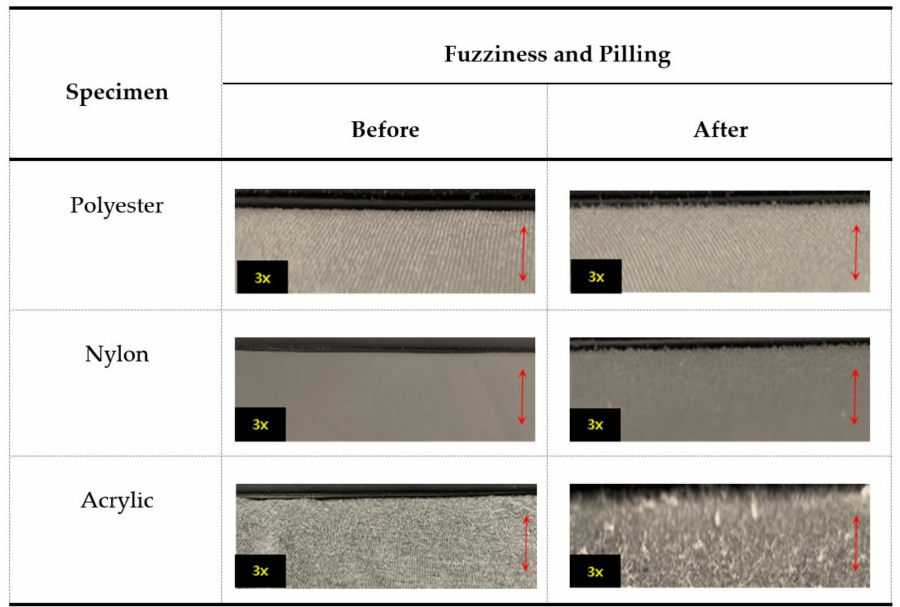
Figure 7. Digital microscopy images (3 × ) of the fuzziness and pilling on fabric surfaces resulting from washing and